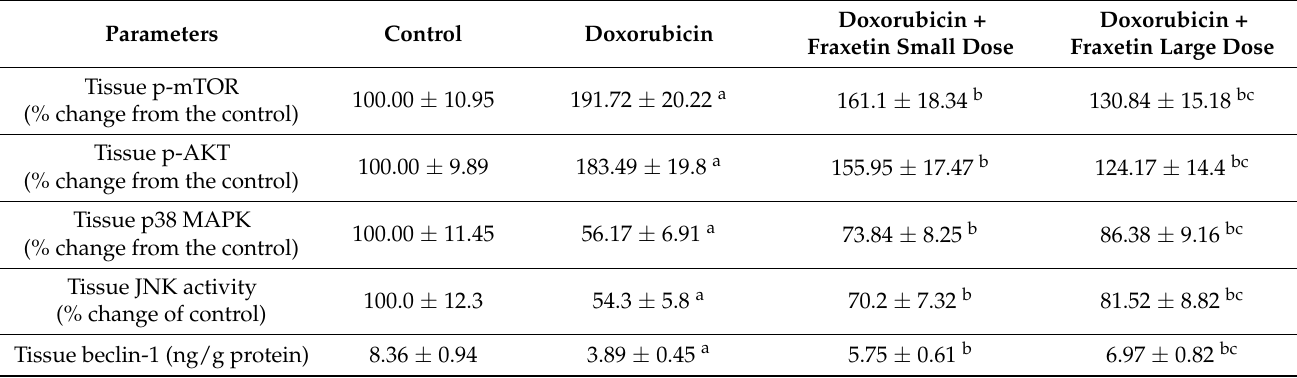
Table 2. Effect of different doses of fraxetin on cardiac tissue p-mTOR, p-AKT, p38 MAP kinase, JNK activity, and beclin-1 levels in doxorubicin-treated animals (mean ± SD).